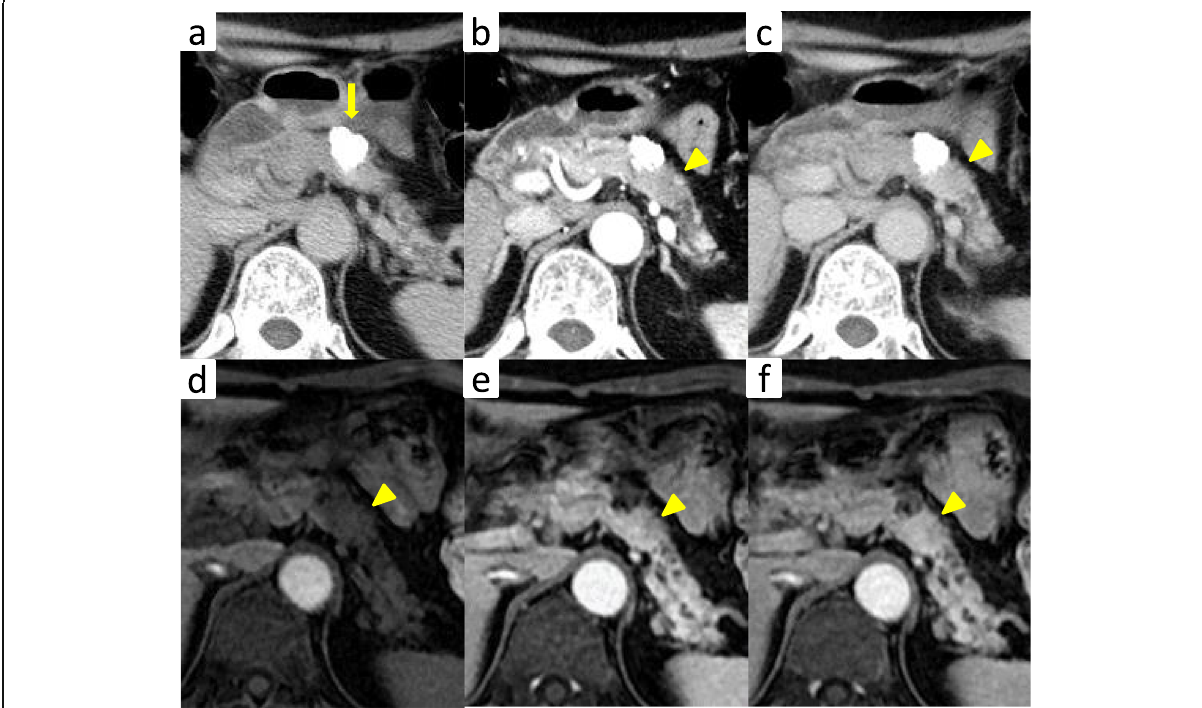
Fig. 1 Plain CT, contrast-enhanced CT, and Gd-EOB-DPTA-enhanced MRI. Plain CT showing a calcification on the head side of the nodule (yellow arrowhead). Contrast-enhanced CT and Gd-EOB-DPTA-enhanced MRI showing a 21-mm nodule that showed gradually intense enhancement in the pancreatic body (yellow arrow). a Plain CT. b Arterial phase of CT. c Equilibrium phase. d Pre-enhancement phase of MRI. e Early phase of MRI. f Late phase of MRI. CT, computed tomography; Gd-EOB-DPTA, gadolinium-ethoxybenzyl-diethylenetriamine; MRI, magnetic resonance